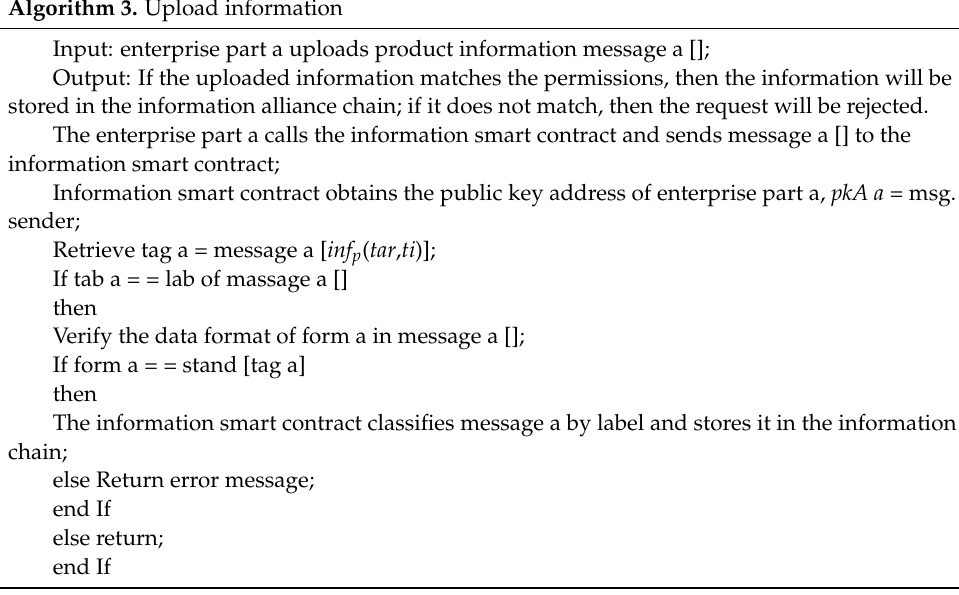
Algorithm 3. Upload